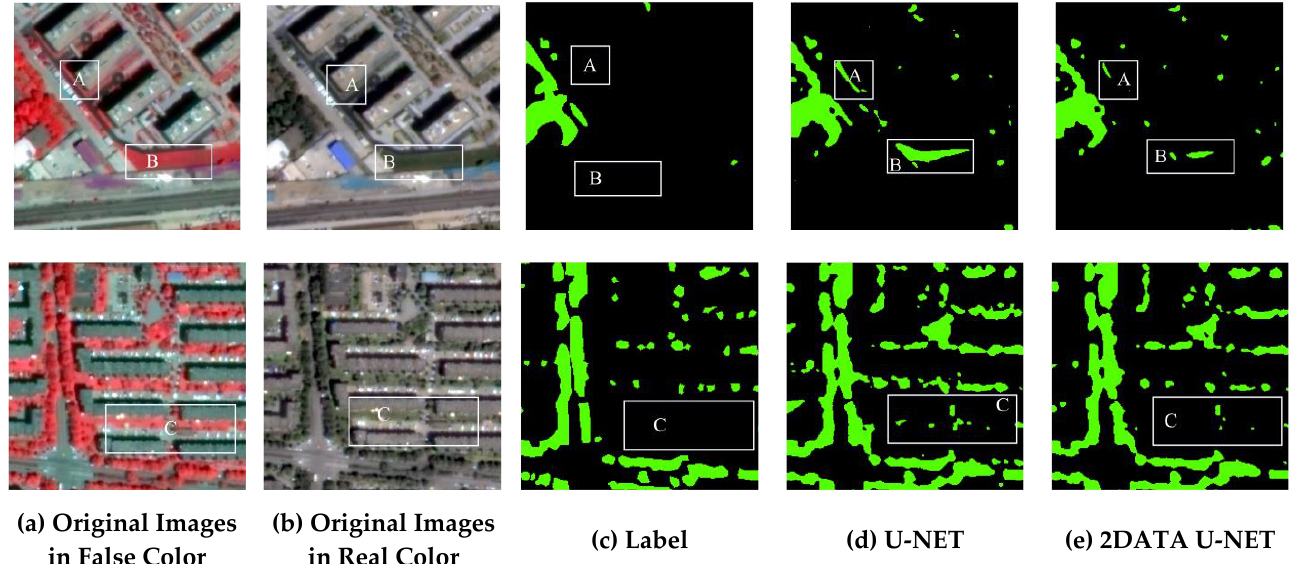
Figure 10. Comparison of classification results of mono-temporal images and multi-temporal images: (a) original images in false color, (b) original images in real color, (c) ground truth, (d) classification results of U-NET (mono-temporal images), (e) classification results of 2DATA U-NET.